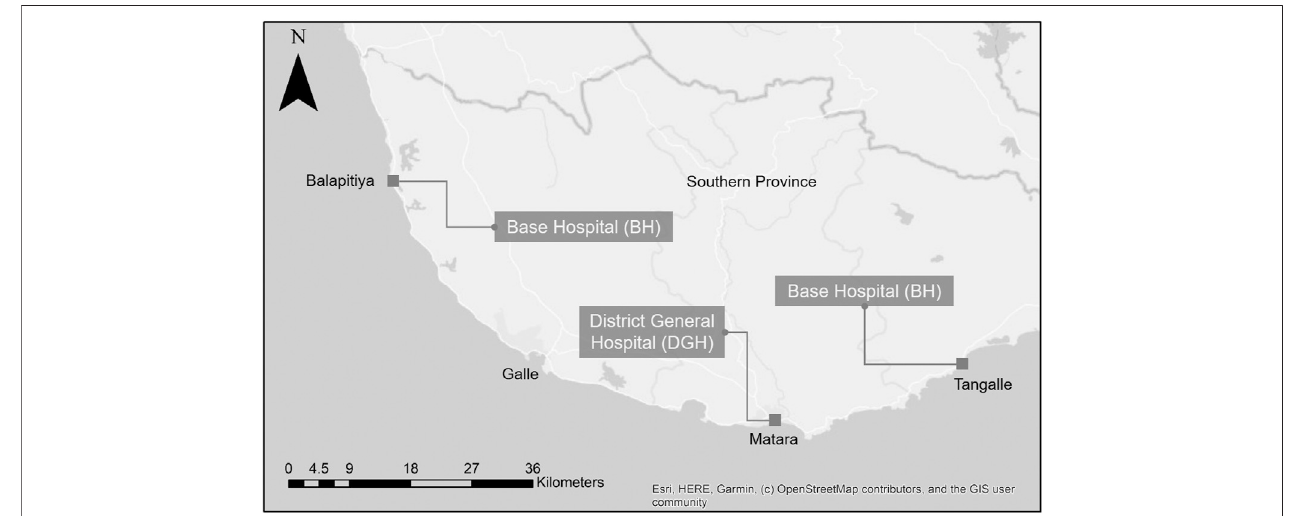
FIGURE 4 | Case-study hospitals in Southern Province, Sri Lanka.